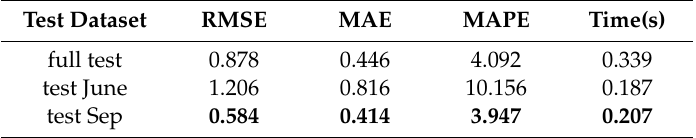
Table 8. Y(1) Prediction of the proposed models built with the chosen data whose size is